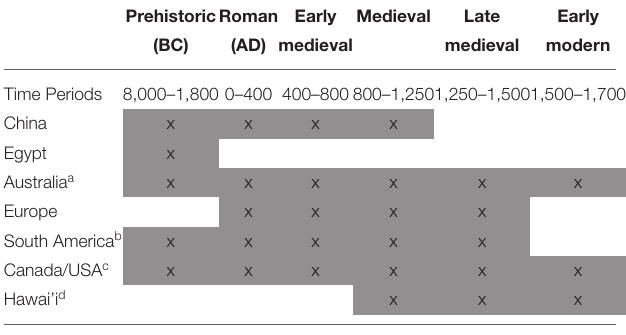
TABLE 1 | Main historical periods of the seven case studies